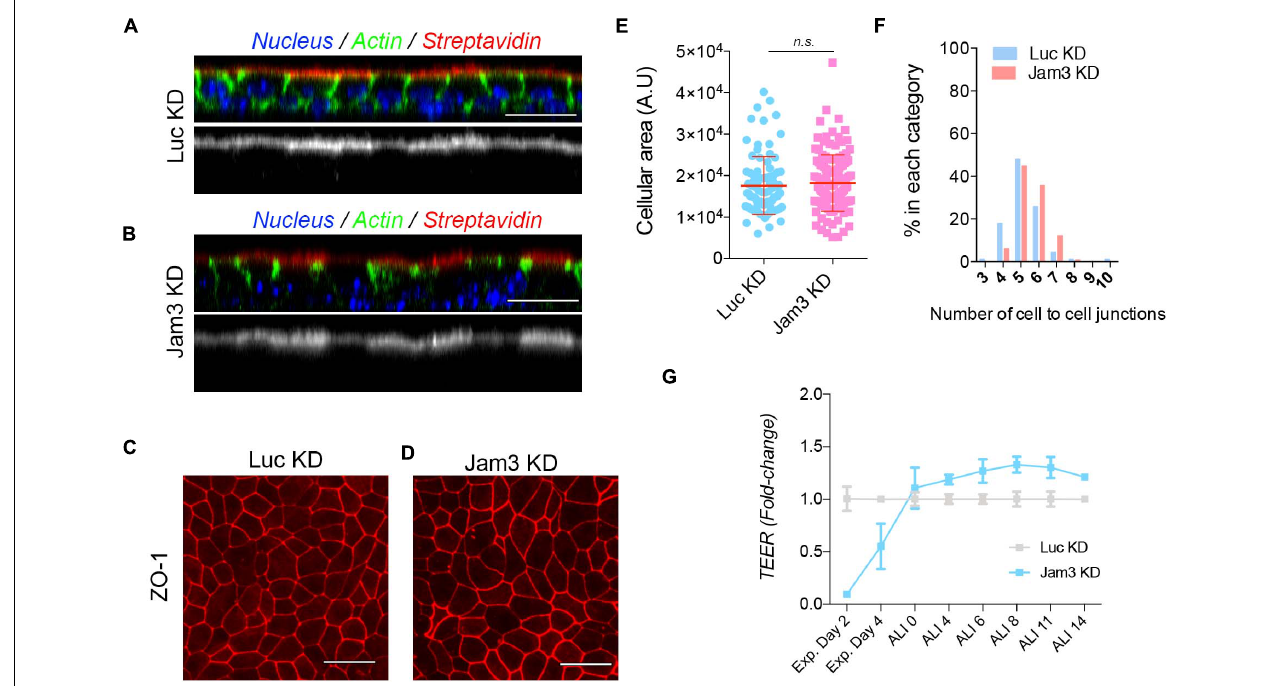
FIGURE 5 | Downregulation of Jam3 expression does not affect epithelial integrity but delays airway epithelial monolayer TEER during expansion. (A) Confocal images corresponding to orthogonal views in MTECs control (A) and Jam3 KD cells (B) . Streptavidin Alexa 555 (in red) was only observed at the apical membrane. Phalloidin (in green) was used to label the cortical actin in both the apical and basolateral surfaces and Dapi (in blue) for nucleus. (C,D) Confocal images to evaluate ZO-1 recruitment to the junction in Luc KD (C) and Jam3 KD (D) cells. (E,F) Cell size (E) and cell–cell contact number (F) evaluation in confocal images of ZO-1 in Luc KD and Jam3 KD cells. (G) Transepithelial resistance (TEER) measure was used to test tight-junction permeability during the differentiation process of MTECs in Jam3-KD compared to Luc-KD cells. Scale bar in panels (A–D) represents 20 µ m. p -values in all conditions were obtained using t